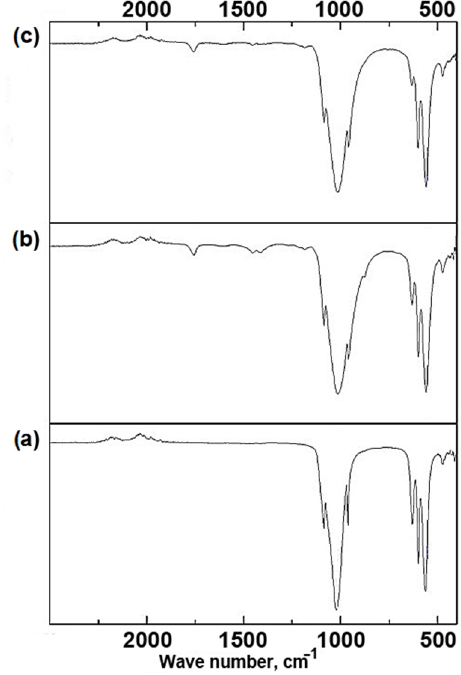
Figure 3. IR spectra of ( a ) Zn x HA (x = 0.1), ( b ) Zn x HA-PLGA (x = 0.1), ( c ) Zn x HA-PLGA (x = 0.5) samples.